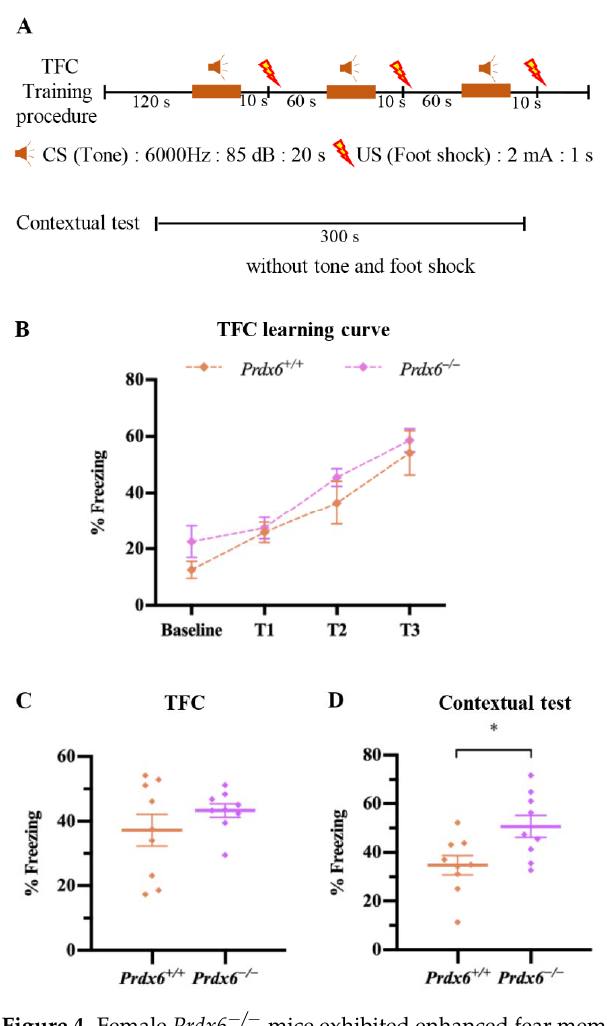
Figure 4. Female Prdx6 − / − mice exhibited enhanced fear memory retrieval to context. ( A ) Illustration of trace fear conditioning procedure and contextual test ( B ) The learning curve for baseline and three trials of TFC training ( Prdx6 +/+ , n = 9 and Prdx6 − / − , n = 9). ( C ) The total percentage of freezing of training sessions. ( D ) The total percentage of freezing of contextual test. All data are presented as mean ± SEM, * p < 0.05. TFC, trace fear conditioning; PRDX6, peroxiredoxin 6.